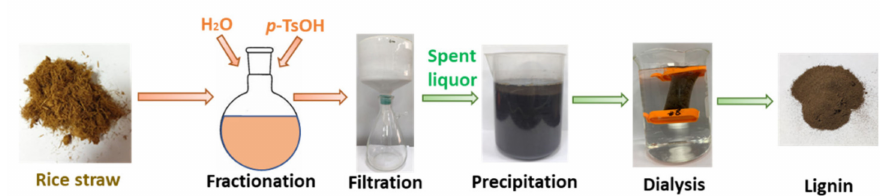
Figure 1. Experimental schematic flow diagram.